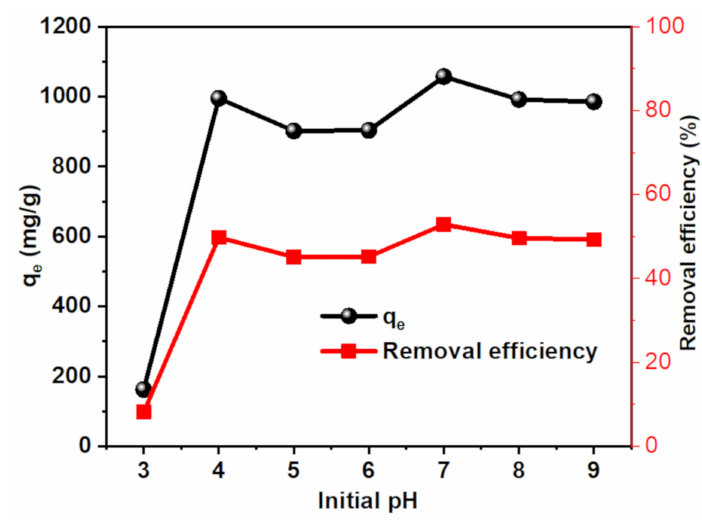
Figure 8. E ff ect of pH on the adsorption capability of MB by CT- g -PAA /